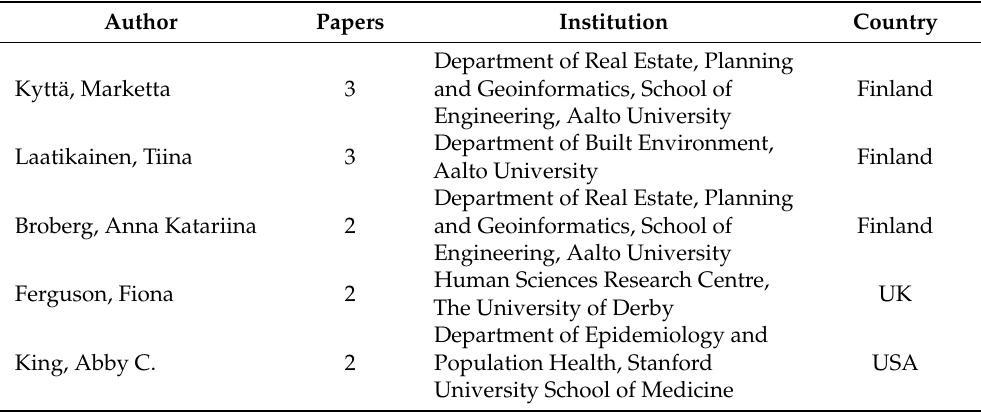
Table 2. Most recurring authors assessing citizens’ perception through digital